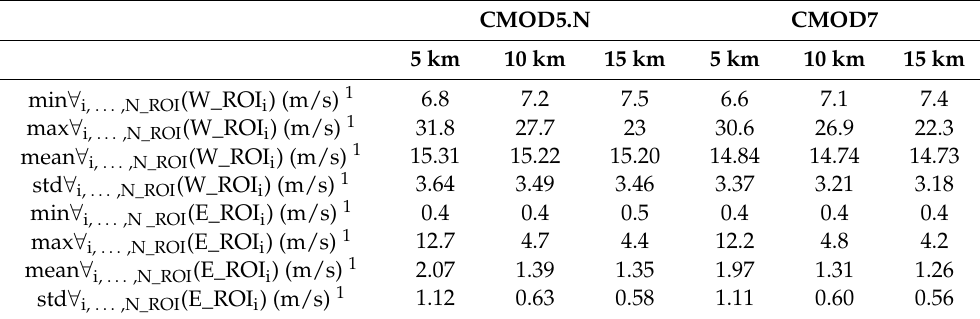
Table 2. Statistics about the SAR SSW speed (m/s) and the related uncertainty (m/s) for all ROIs, at various dimensions and for two different applied Geophysical Model Functions